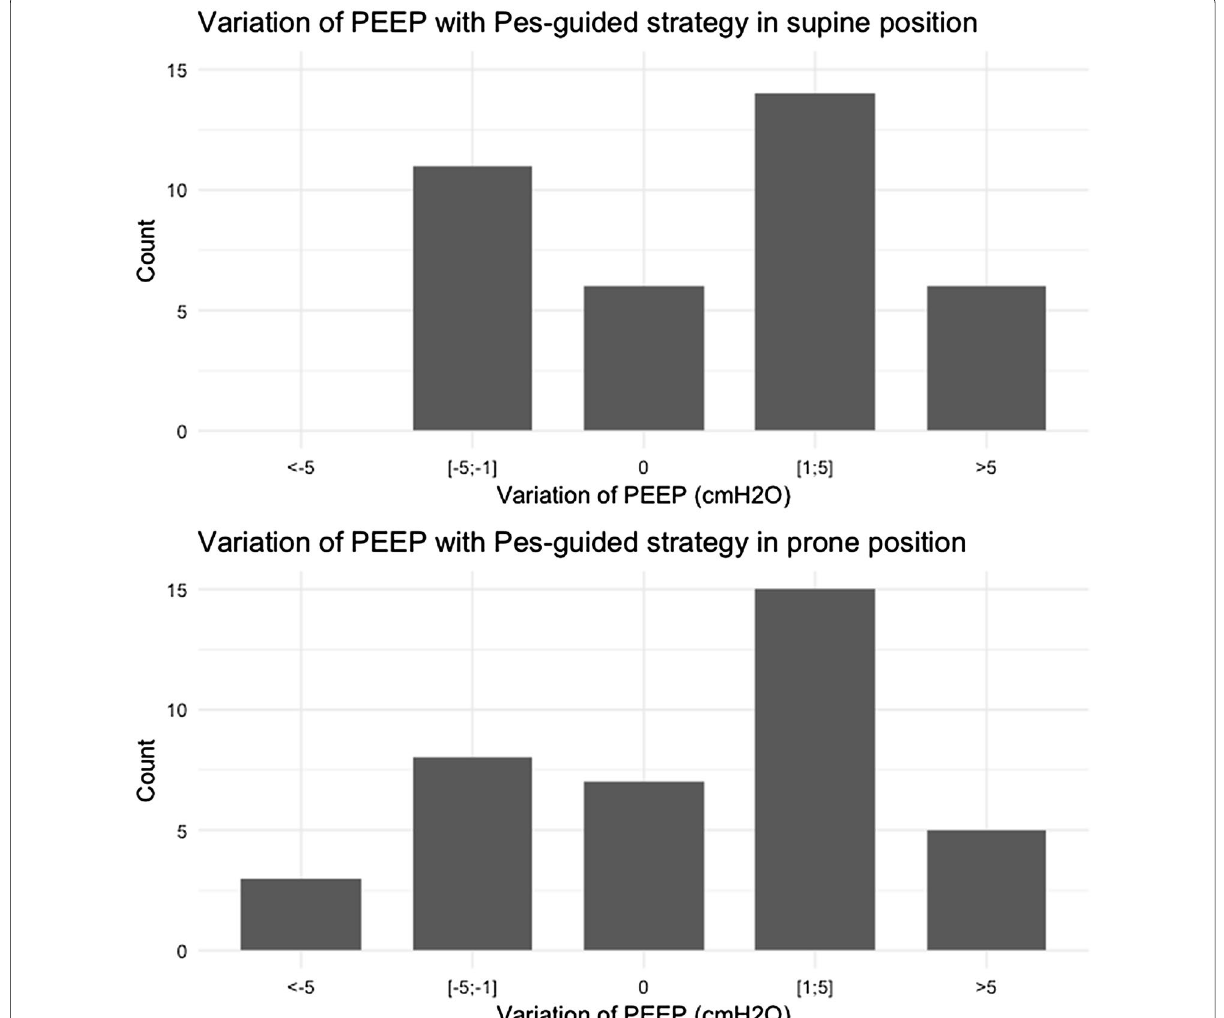
Fig. 2 Variation of positive end‑expiratory pressure (PEEP) with esophageal pressure (Pes)‑guided strategy in supine and prone